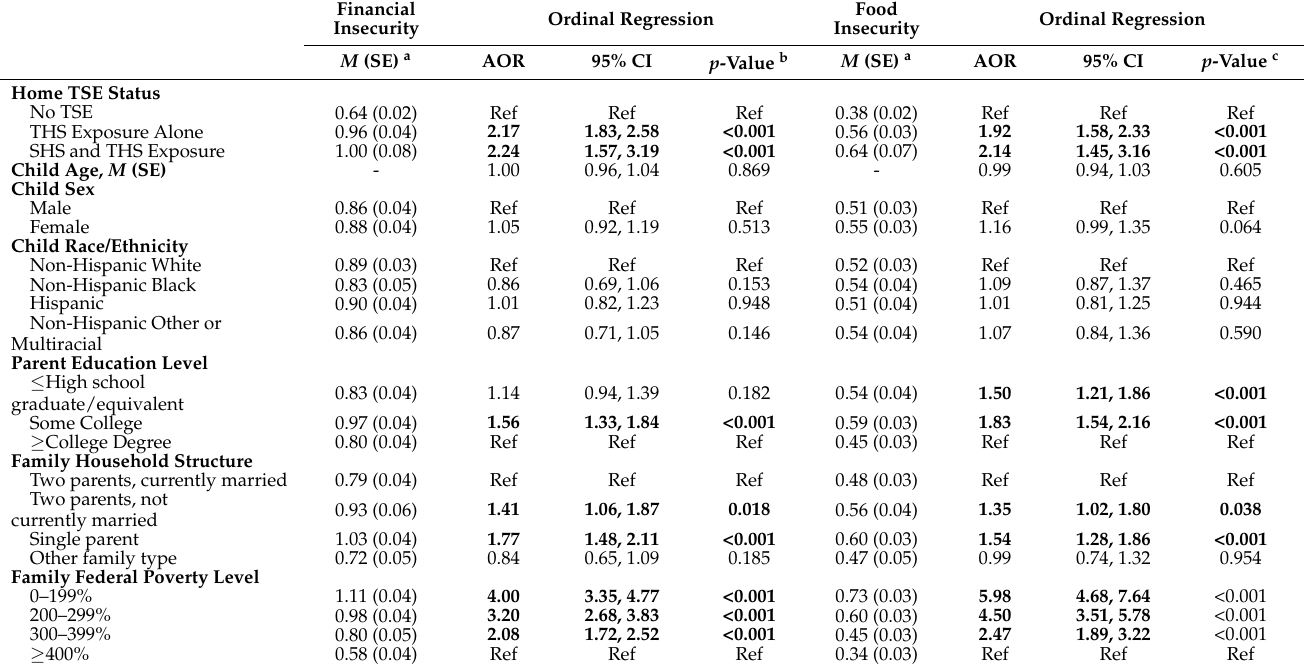
Table 2. Child Home TSE Status and Financial Insecurity and Food Insecurity among U.S.